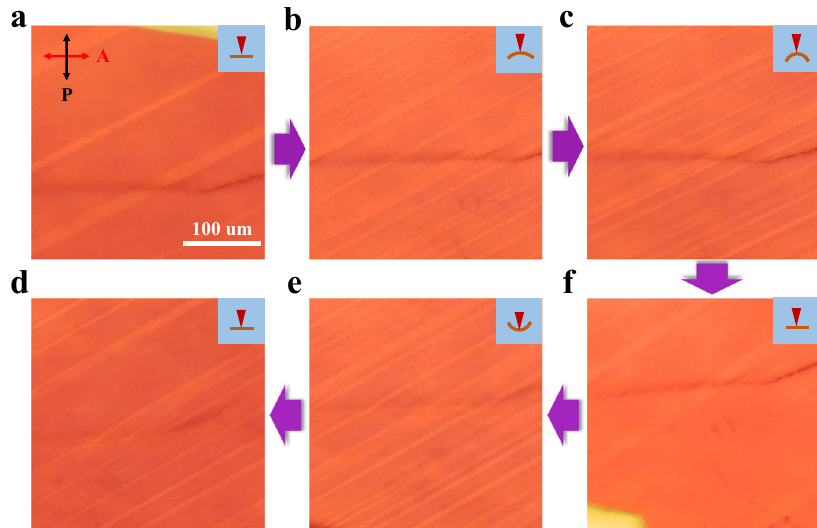
Fig. 1 In-situ observation of ferroelastic domain motion in BAI-N2 single-crystalline layered perovskites by polarized optical microscope. a – f are in-situ polarized optical microscope images of the domain wall movement under applied stress in BAI-N2 crystals. The purple arrow indicates the bending sequence. The inset images show the bending states of the BAI-N2 single crystals and the red triangle represents the imaging direction. The red and black arrows in ( a ) indicate the analyzer and polarizer orientation, respectively. The dark line in the center is a surface scratch, which is chosen as a location marker.